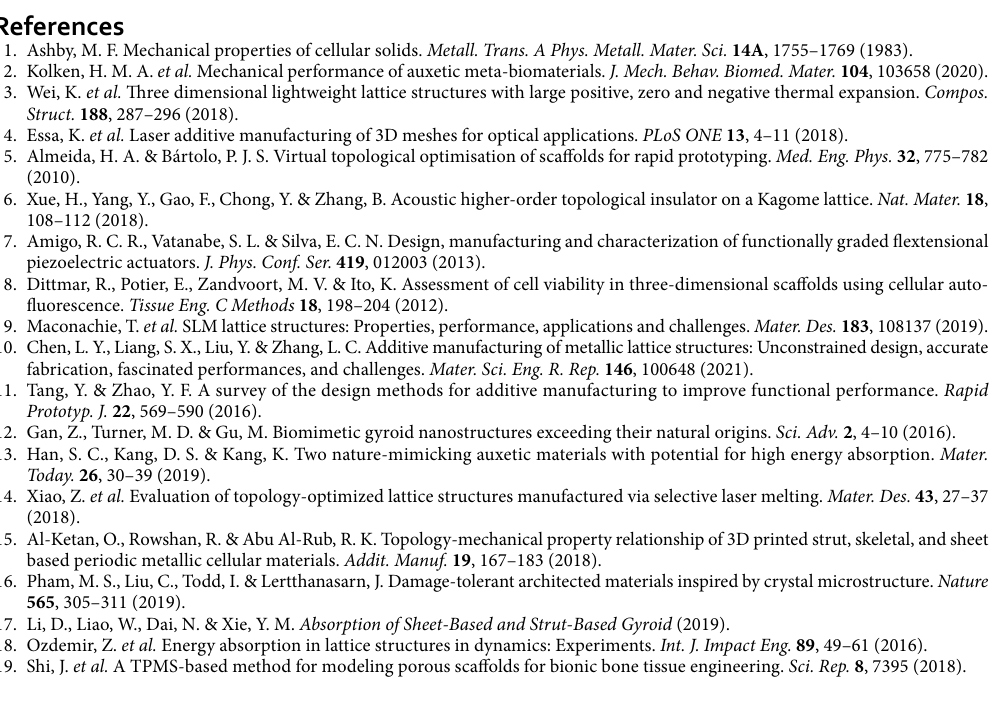
Table 6. Comparison between the PSO and FE result of Young’s modulus and yield strength.